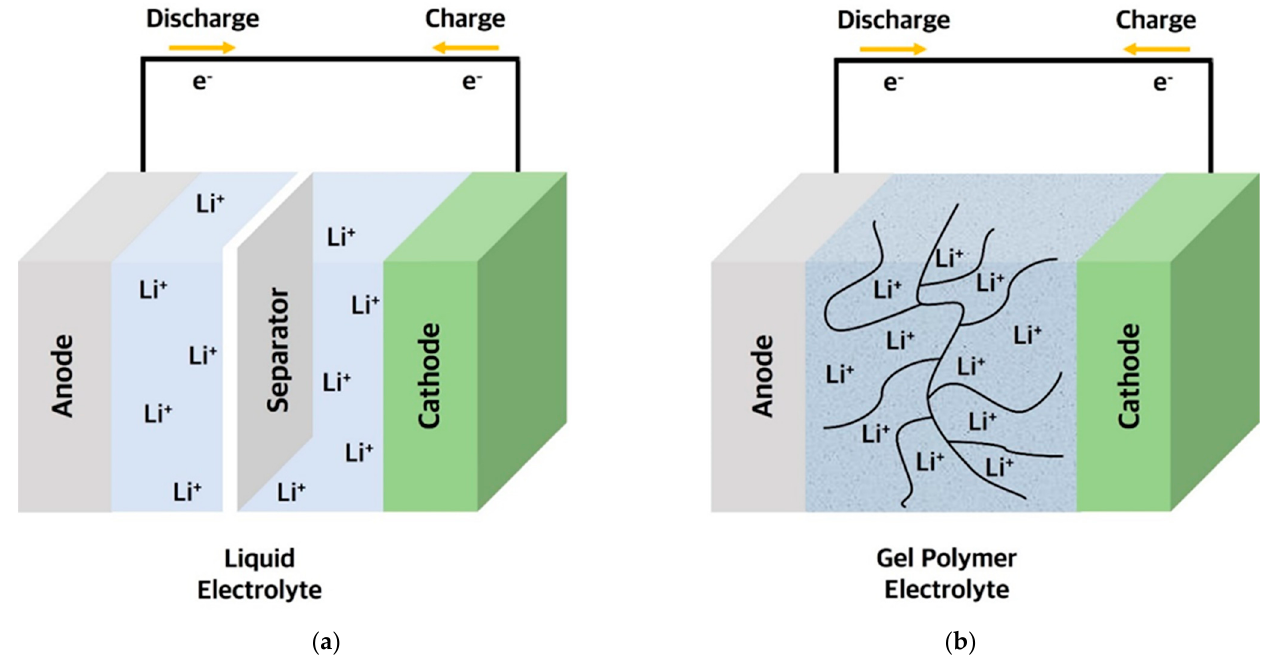
Figure 1. Schematic diagram of lithium batteries using ( a ) liquid electrolyte; and ( b ) gel polymer electrolyte.